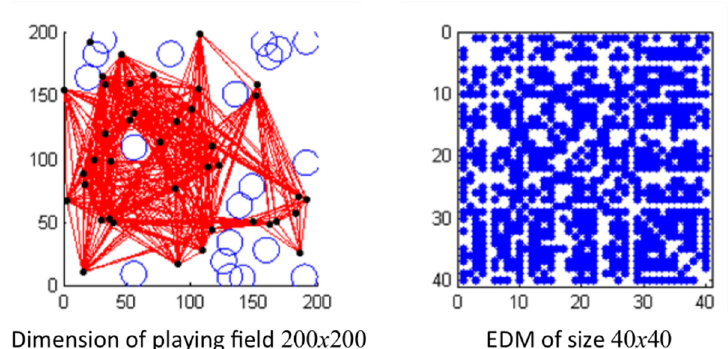
Figure 2. Sensors and the partial Euclidean Distance Matrix (EDM). Left : black dots represent the sensors, blue circles represent the objects, while red lines connect the neighboring sensors (nodes). Right: blue dots represent the entries in the Euclidean Distance Matrix, corresponding to the neighboring sensors